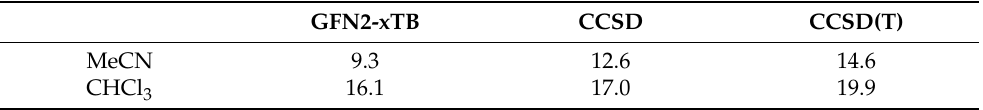
Table 8. Binding energies in kcal/mol for the complexes between the buckycatcher and acetonitrile and chloroform. Data obtained based on GFN2-xTB